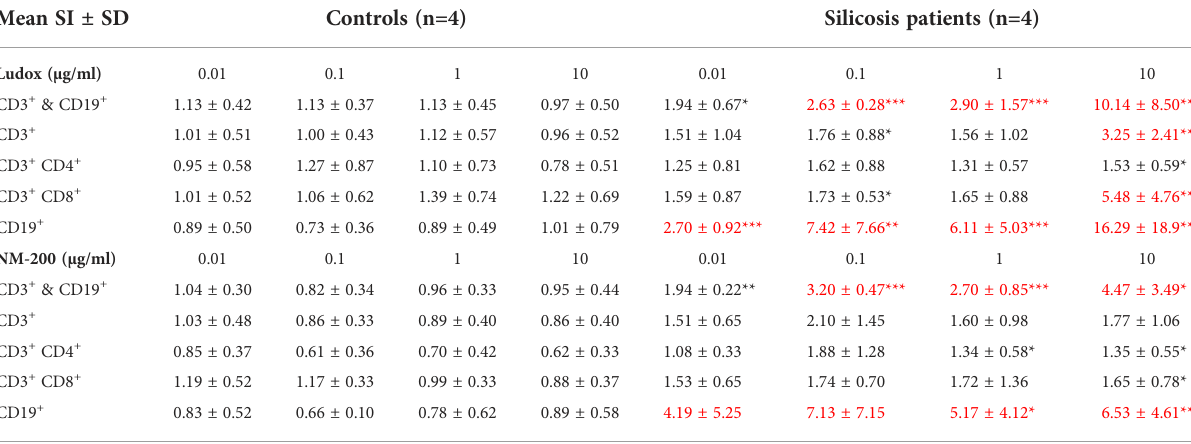
TABLE 3 Mean stimulation index (SI) values ± standard deviation (SD) of all lymphocyte subpopulations, across 4 concentrations of SiNPs- Ludox and NM-200. Mean SI ± SD Controls